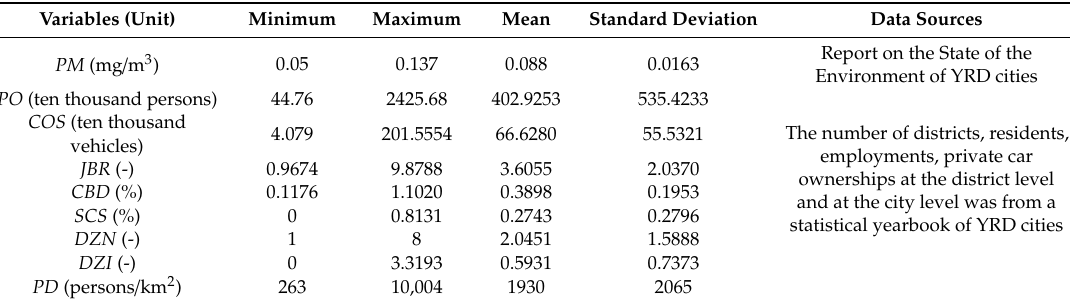
Table 2. Statistics of dependent, independent, and control variables.